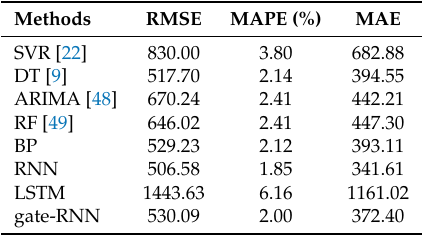
Table 5. Results of eight methods on the 30-min time scale in three months’ test dataset.